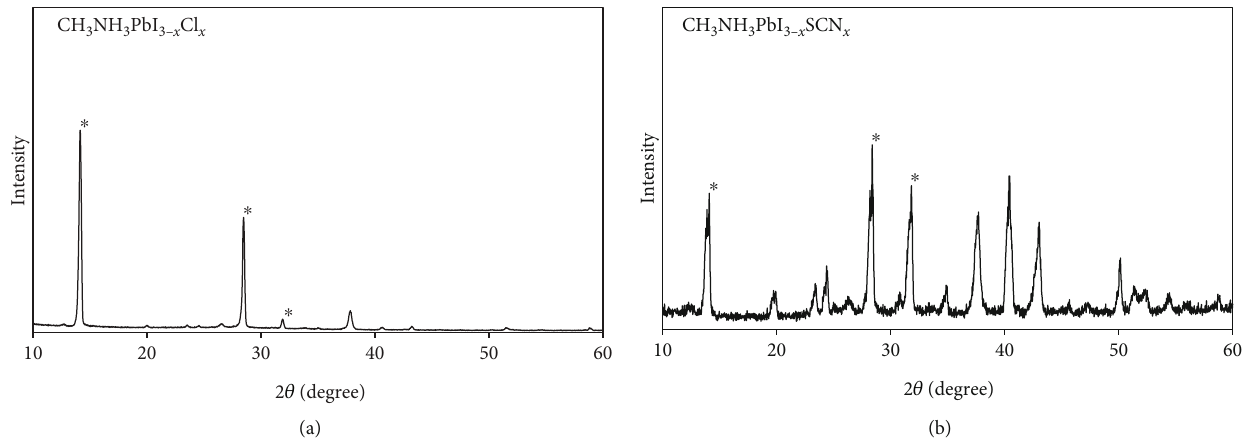
Figure 3: XRD spectra of (a) CH